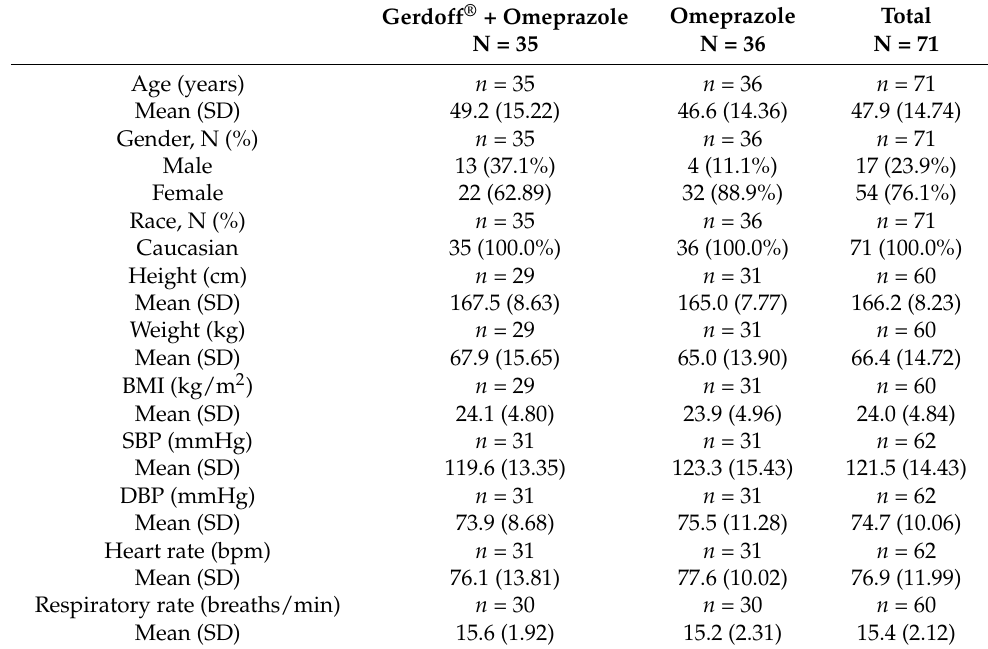
Table 1. Summary of demographic and other baseline characteristics in the randomized population.